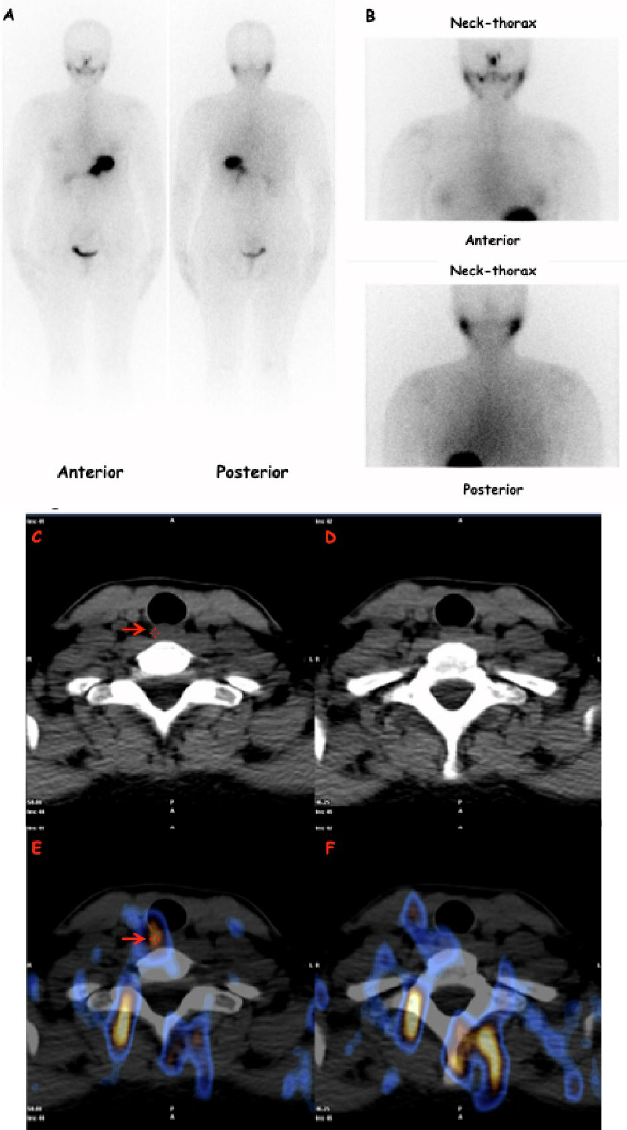
Figure 2. Forty year old woman, pT1b, Nx, Mx-PTC (classic variant), multifocal and bilateral. The largest malignant nodule (14 mm in size) was located in the lower part of the right lobe. ( A ) Dx-WBS (anterior and posterior views) and ( B ) static images (anterior and posterior views) of the neck-thoracic region were obtained 3 h after iodine-123 administration (259 MBq after rhTSH stim-ulation). No pathological radioiodine uptake was noted. On the contrary, axial SPECT-CT images ( C – F ) showed abnormal radioiodine uptake in a small para-tracheal lymph-node (red arrows) of the right central compartment (VI Robbins’ level). At the time of 123I-Dx-WBS-SPECT/CT study, nUs did not show any lymph-node with suspected/pathological features. Basal-Tg was 0.9 ng/mL while early and late-stimulated-Tg levels were <10 ng/mL (2.7 and 7.7 ng/mL, respectively). The patient